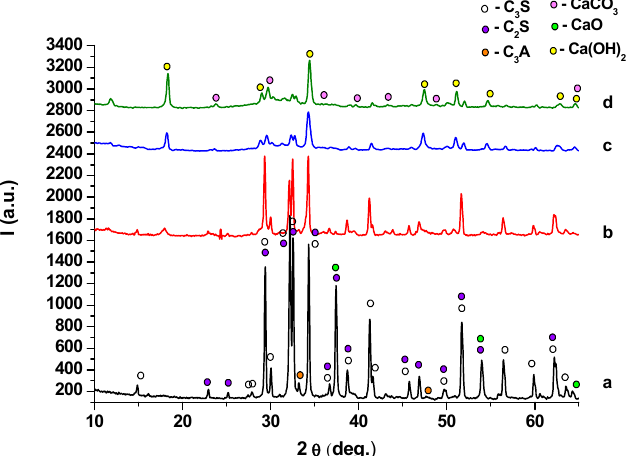
Figure 3. XRD patterns of MTA1: ( a ) anhydrous; ( b ) hydrated for 1 day; ( c ) hydrated for 7 days; ( d ) hydrated for 28 days.